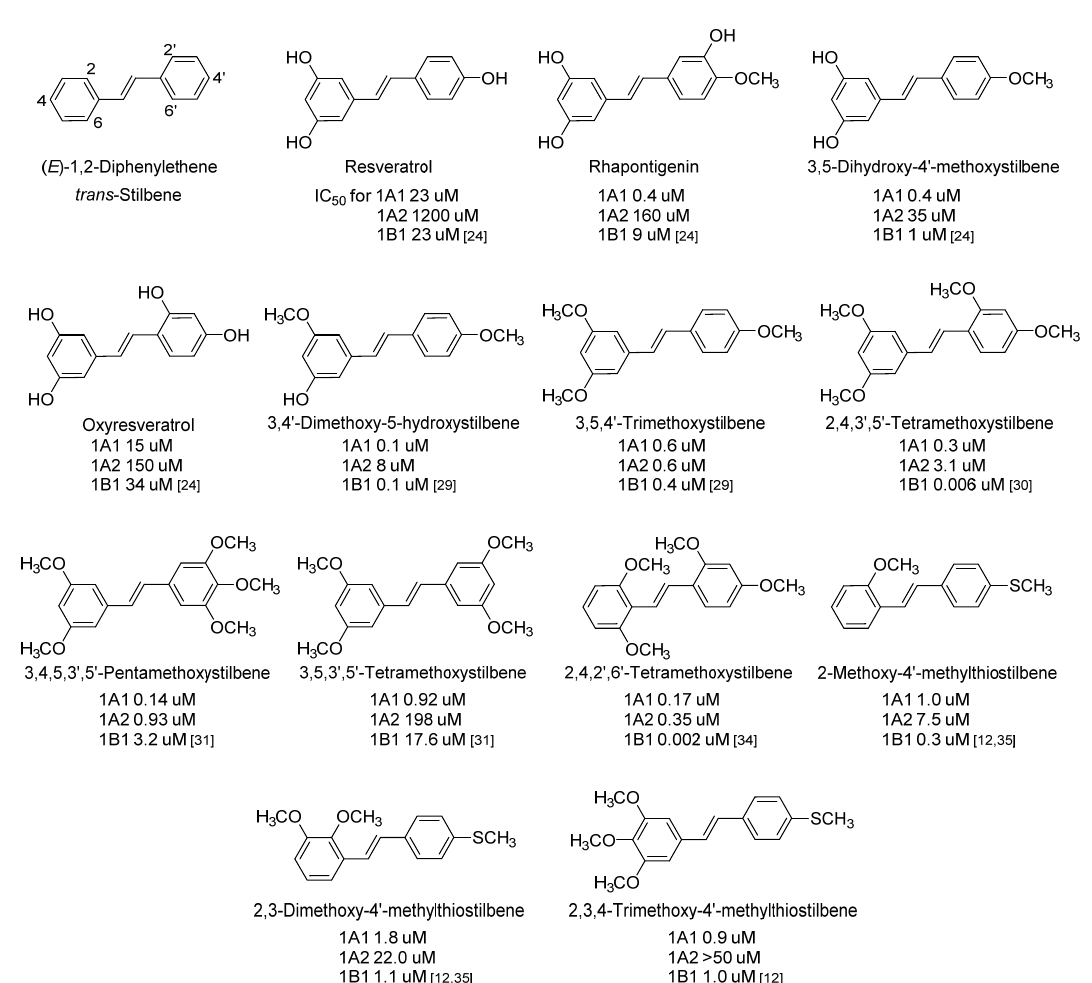
Figure 3. Stilbenoids as P450 1A1, 1A2, and 1B1